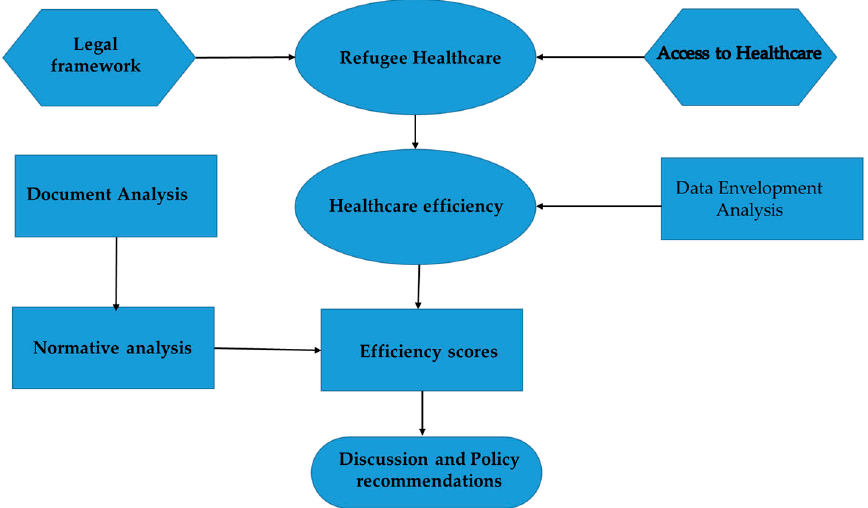
Figure 1. Analysis framework.